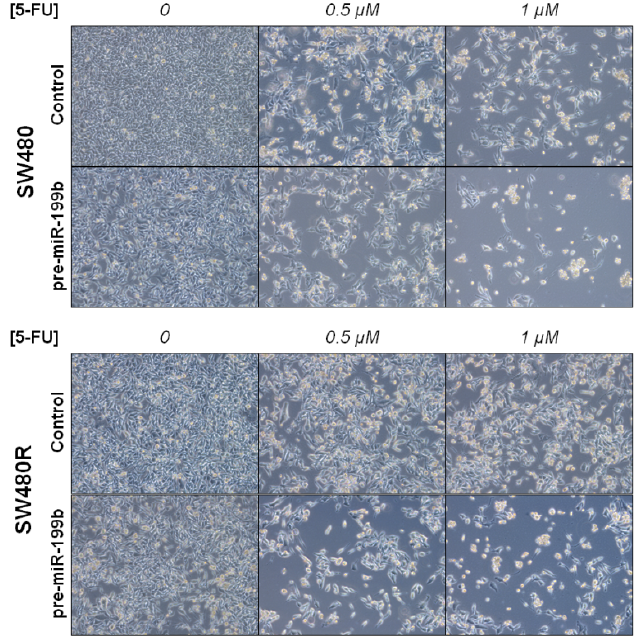
Figure 3. Optical microscope images showing miR-199b-induced changes in cell viability after 5-FU treatment in SW480 and SW480R.